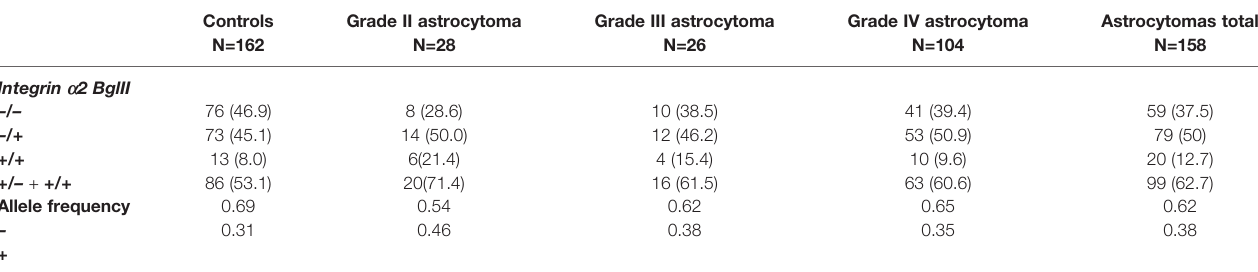
TABLE 1 | Distribution of allele and genotype frequencies of polymorphisms and statistical data obtained from the analysis of integrin a 2 BglII polymorphisms in astrocytoma grades II, III, and IV and control.